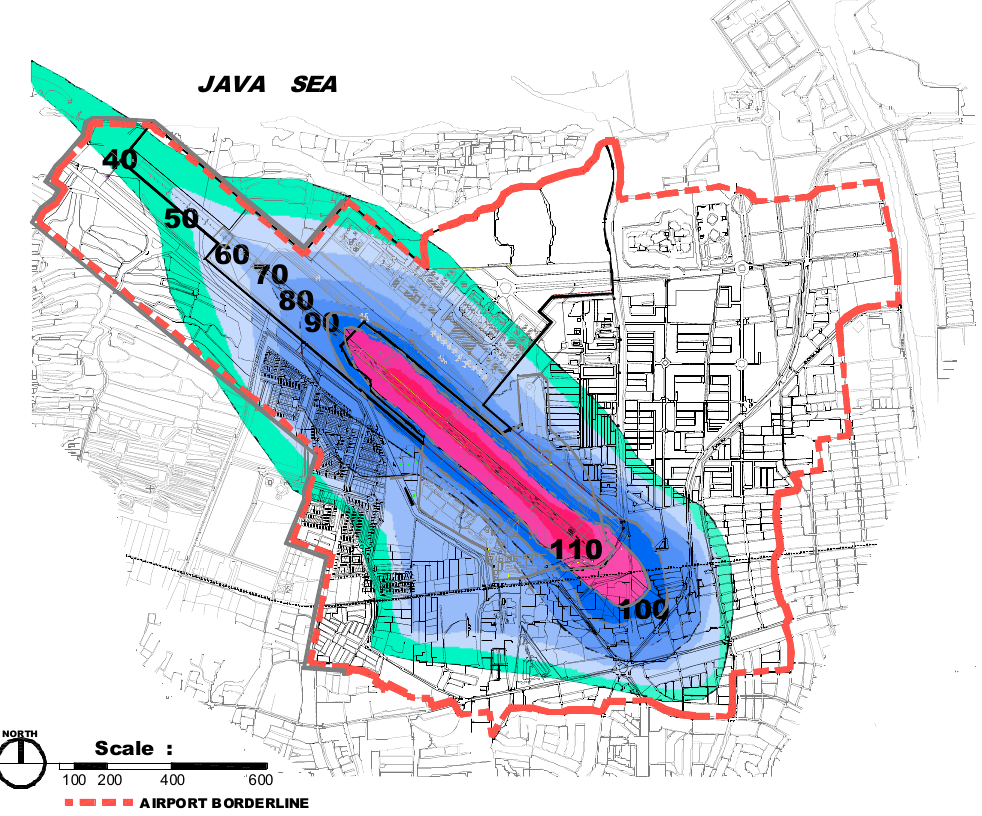
Figure 1. Noise Mapping in Achmad Yani International Airport in Semarang city [33].